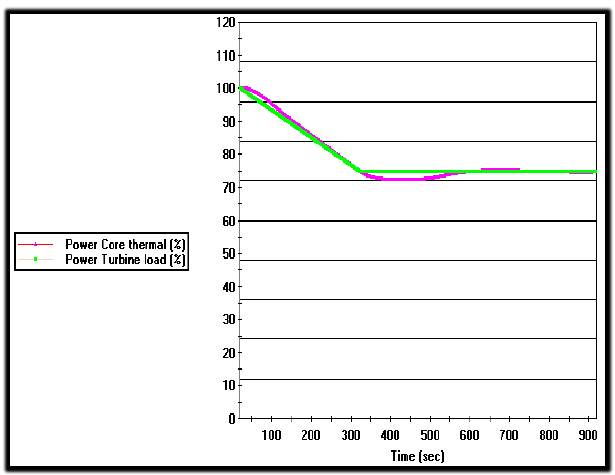
Design Configuration of RI-ANFIS-LV Controllers